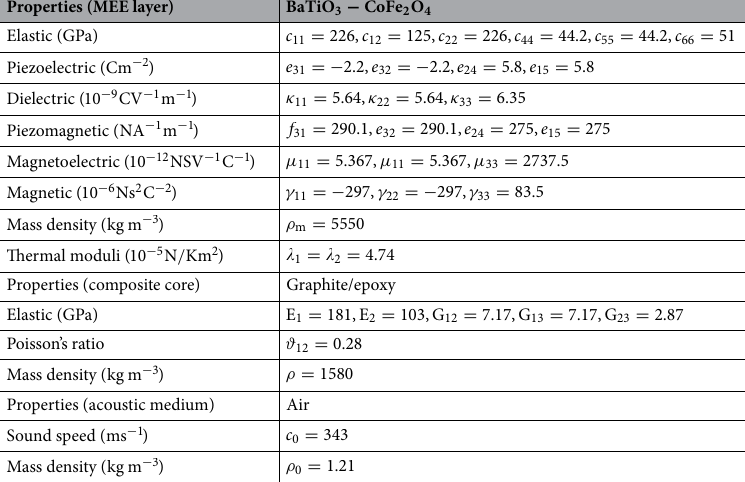
Table 1. Material characteristics of sandwich cross-ply layered MEE plate and acoustic